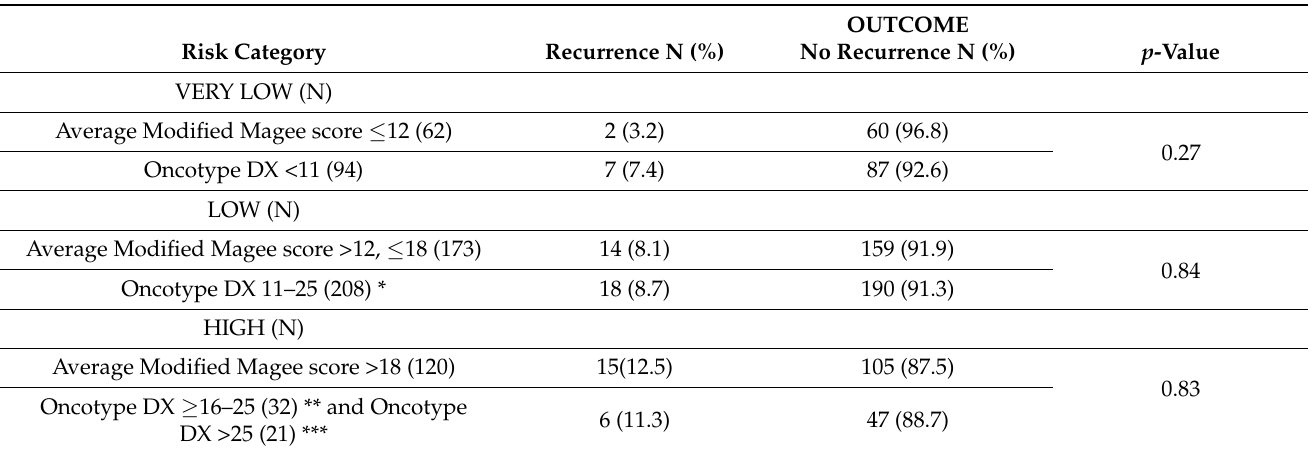
Table 2. Risk categories and outcome.